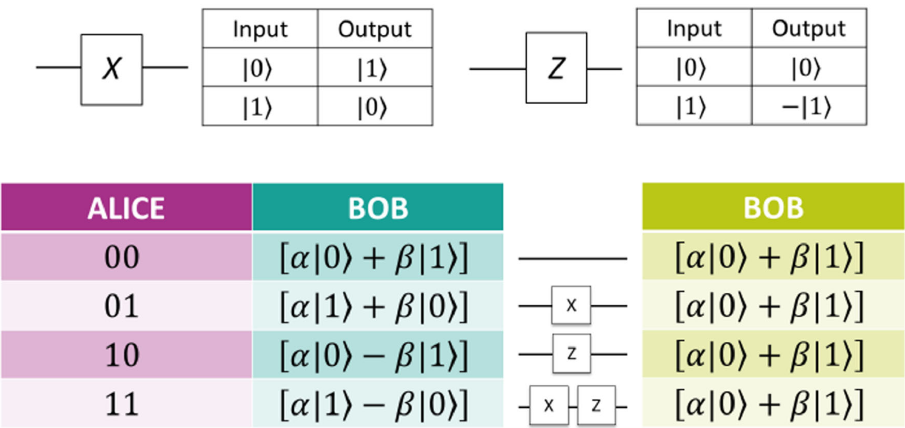
FIG. 17. Application of logic gates to recover the input